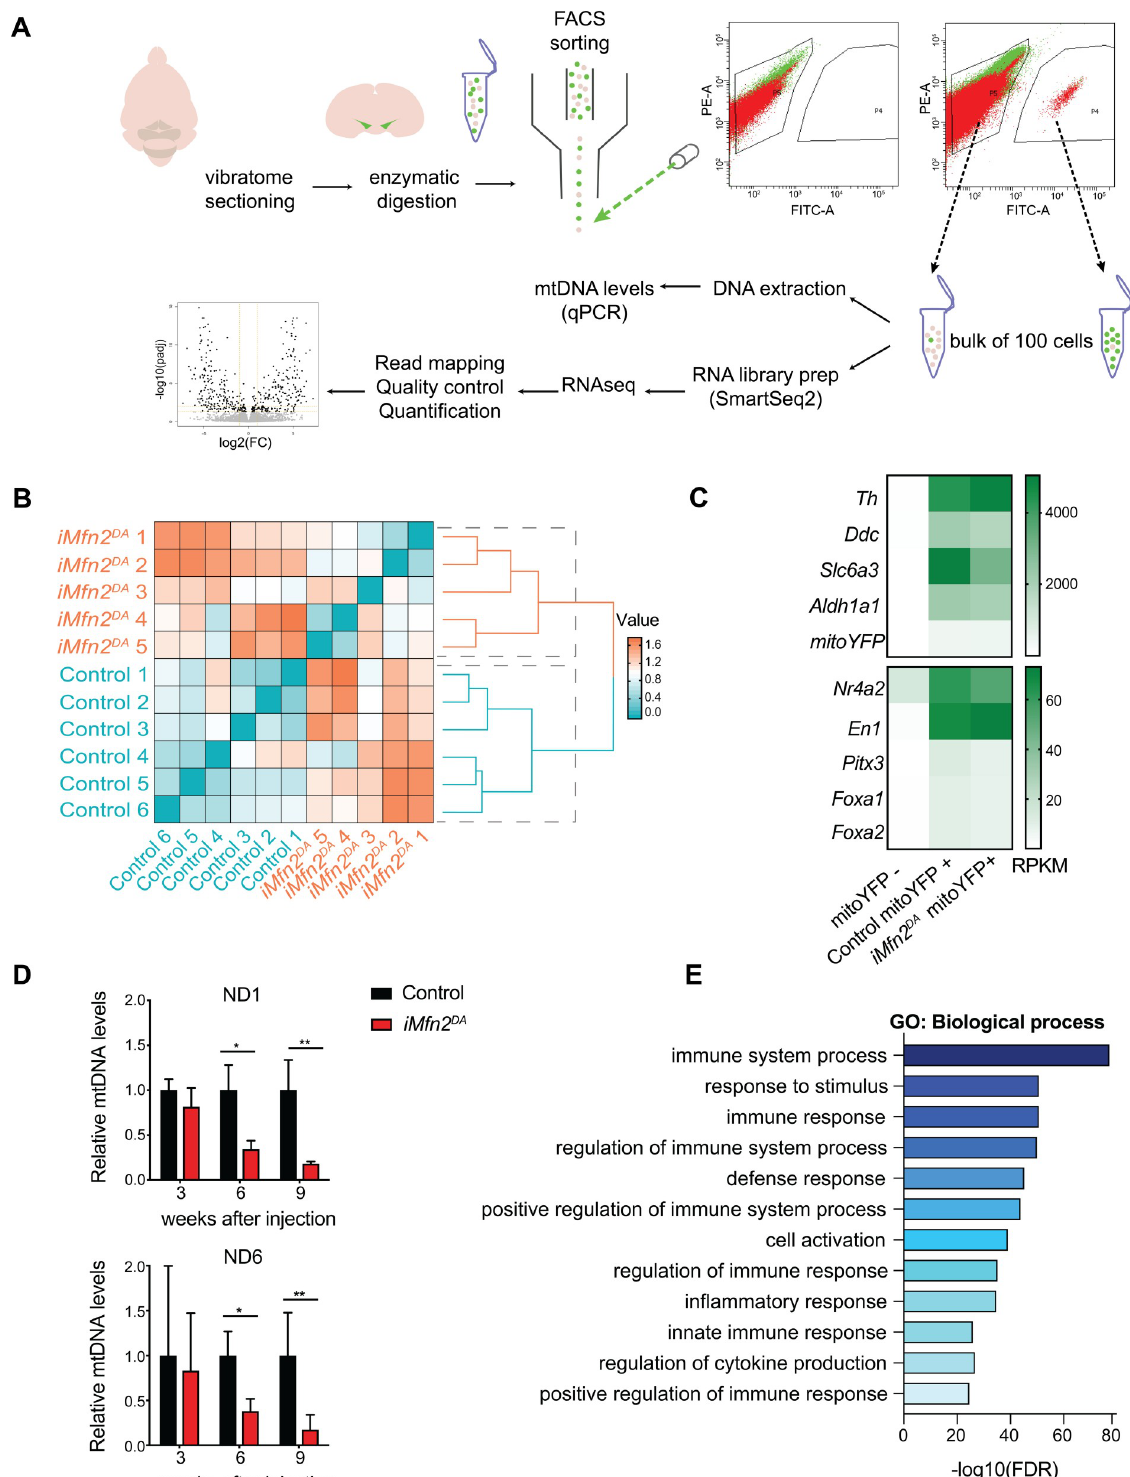
Fig 4. Immune response and mtDNA depletion in tamoxifen-injected iMfn2 DA mouse brains. (A) Experimental workflow: vibratome sections were enzymatically digested and mechanically triturated resulting in a single cell suspension; the bulk of mitoYFP positive (mitoYFP +) cells and mitoYFP negative (mitoYFP-) cells were collected by FACS; samples were used for either mtDNA quantification or for RNA